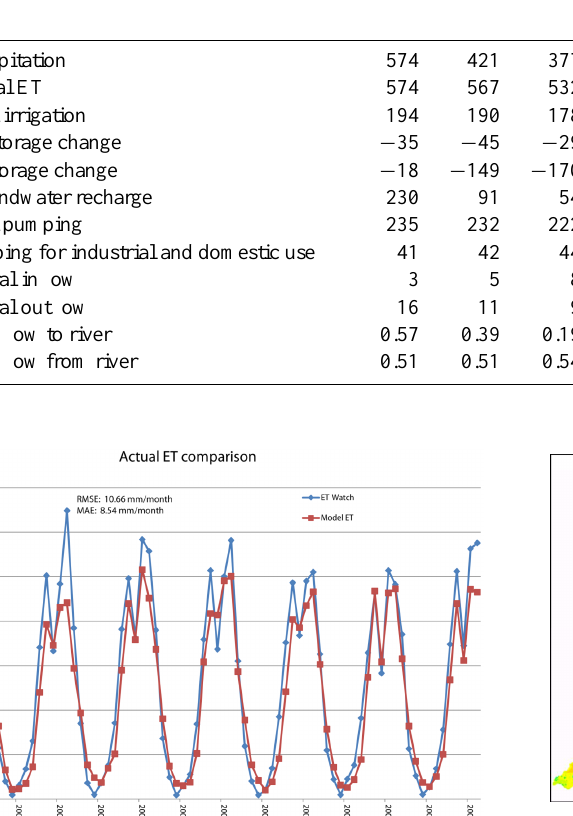
Fig.8. Annually aggregated ET from the model and from ET-Watch. The spatial resolution of 1036 Fig. 8. Annually aggregated ET from the model and from ETWatch. the model ET is 2 km while it is 1 km for the ET-Watch data. The same color scale is 1037 The spatial resolution of the model ET is 2km while it is 1km applied to the two datasets. Only part of the model domain covered by both products have 1038 for the ETWatch data. The same color scale is applied to the two been considered, which mainly excludes some areas along the south-eastern part of the 1039 data sets. Only part of the model domain covered by both products model domain. 1040 have been considered, which mainly excludes some areas along the southeastern part of the model